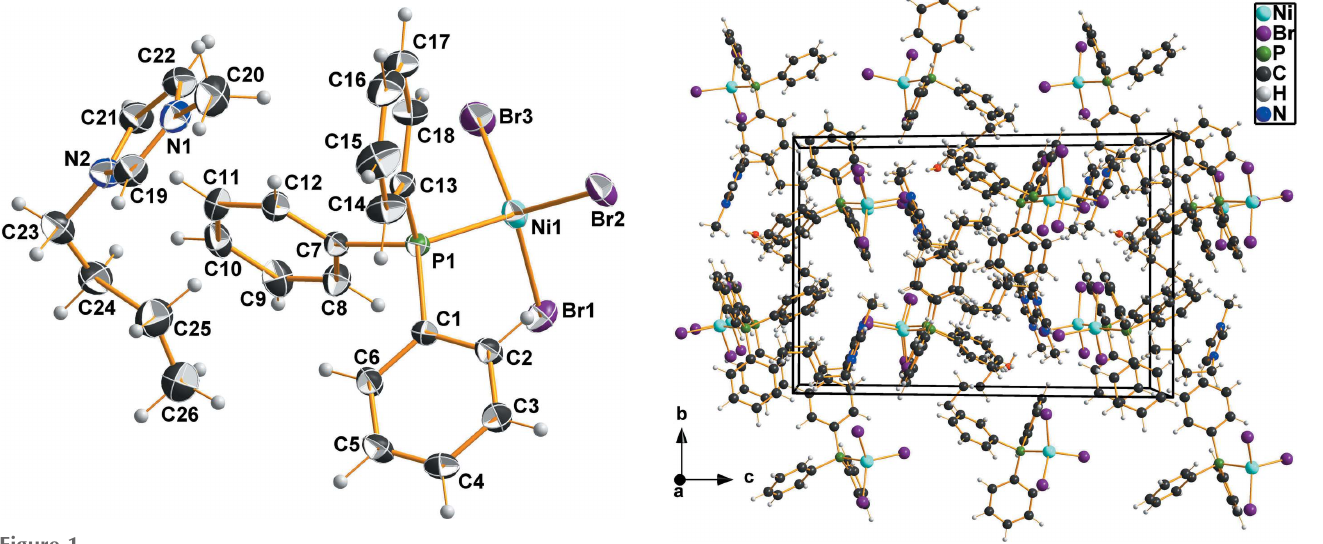
Figure 2 A view of the unit-cell contents of the title compound in a projection down the a